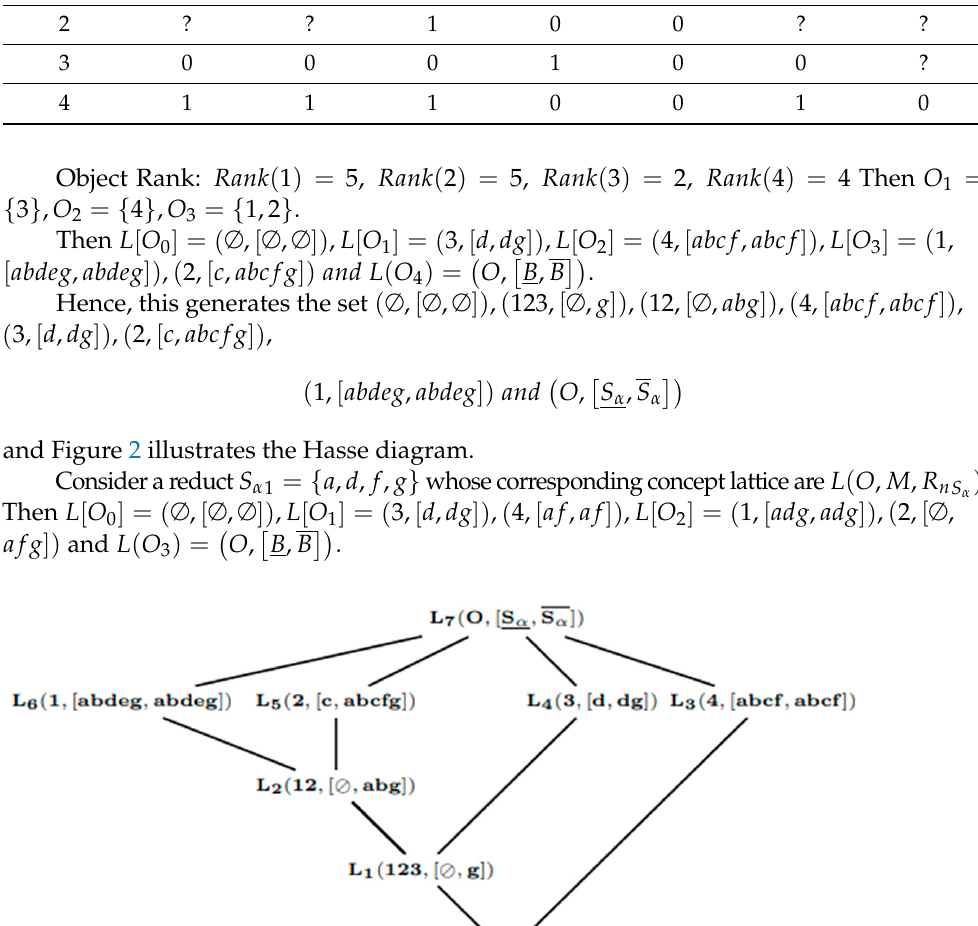
Figure 3. Reduct 𝑆 (cid:3080)(cid:2869) .